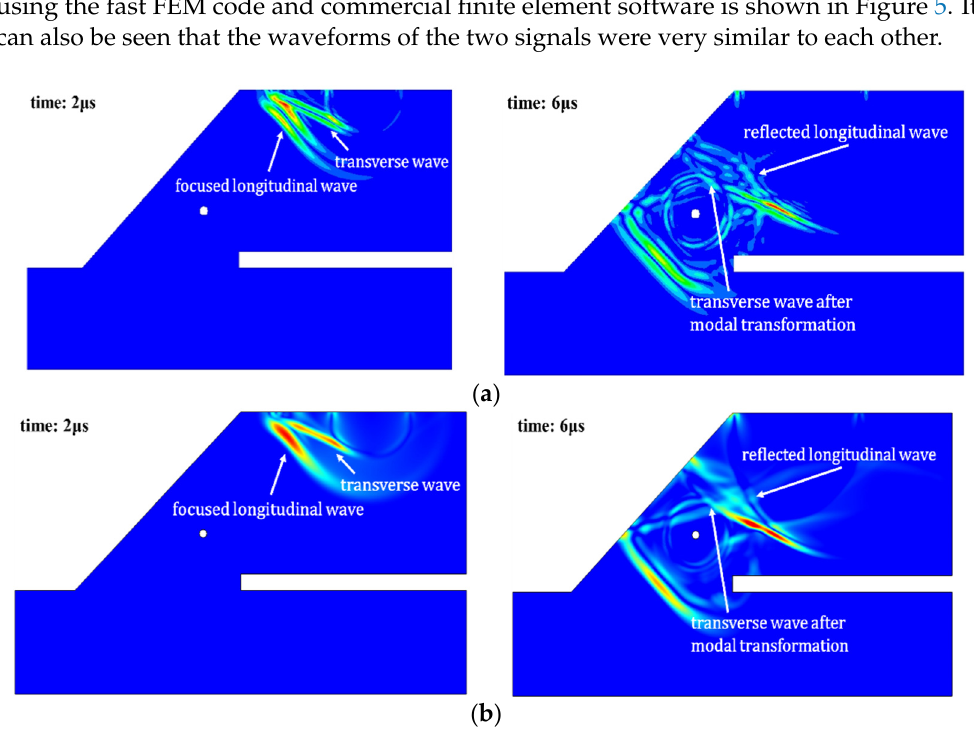
Figure 4. Simulated PA longitudinal wave focusing fields with a focusing angle of 56 ◦ and focusing depth of 27 mm using ( a ) the fast FEM code and ( b ) commercial finite element software.